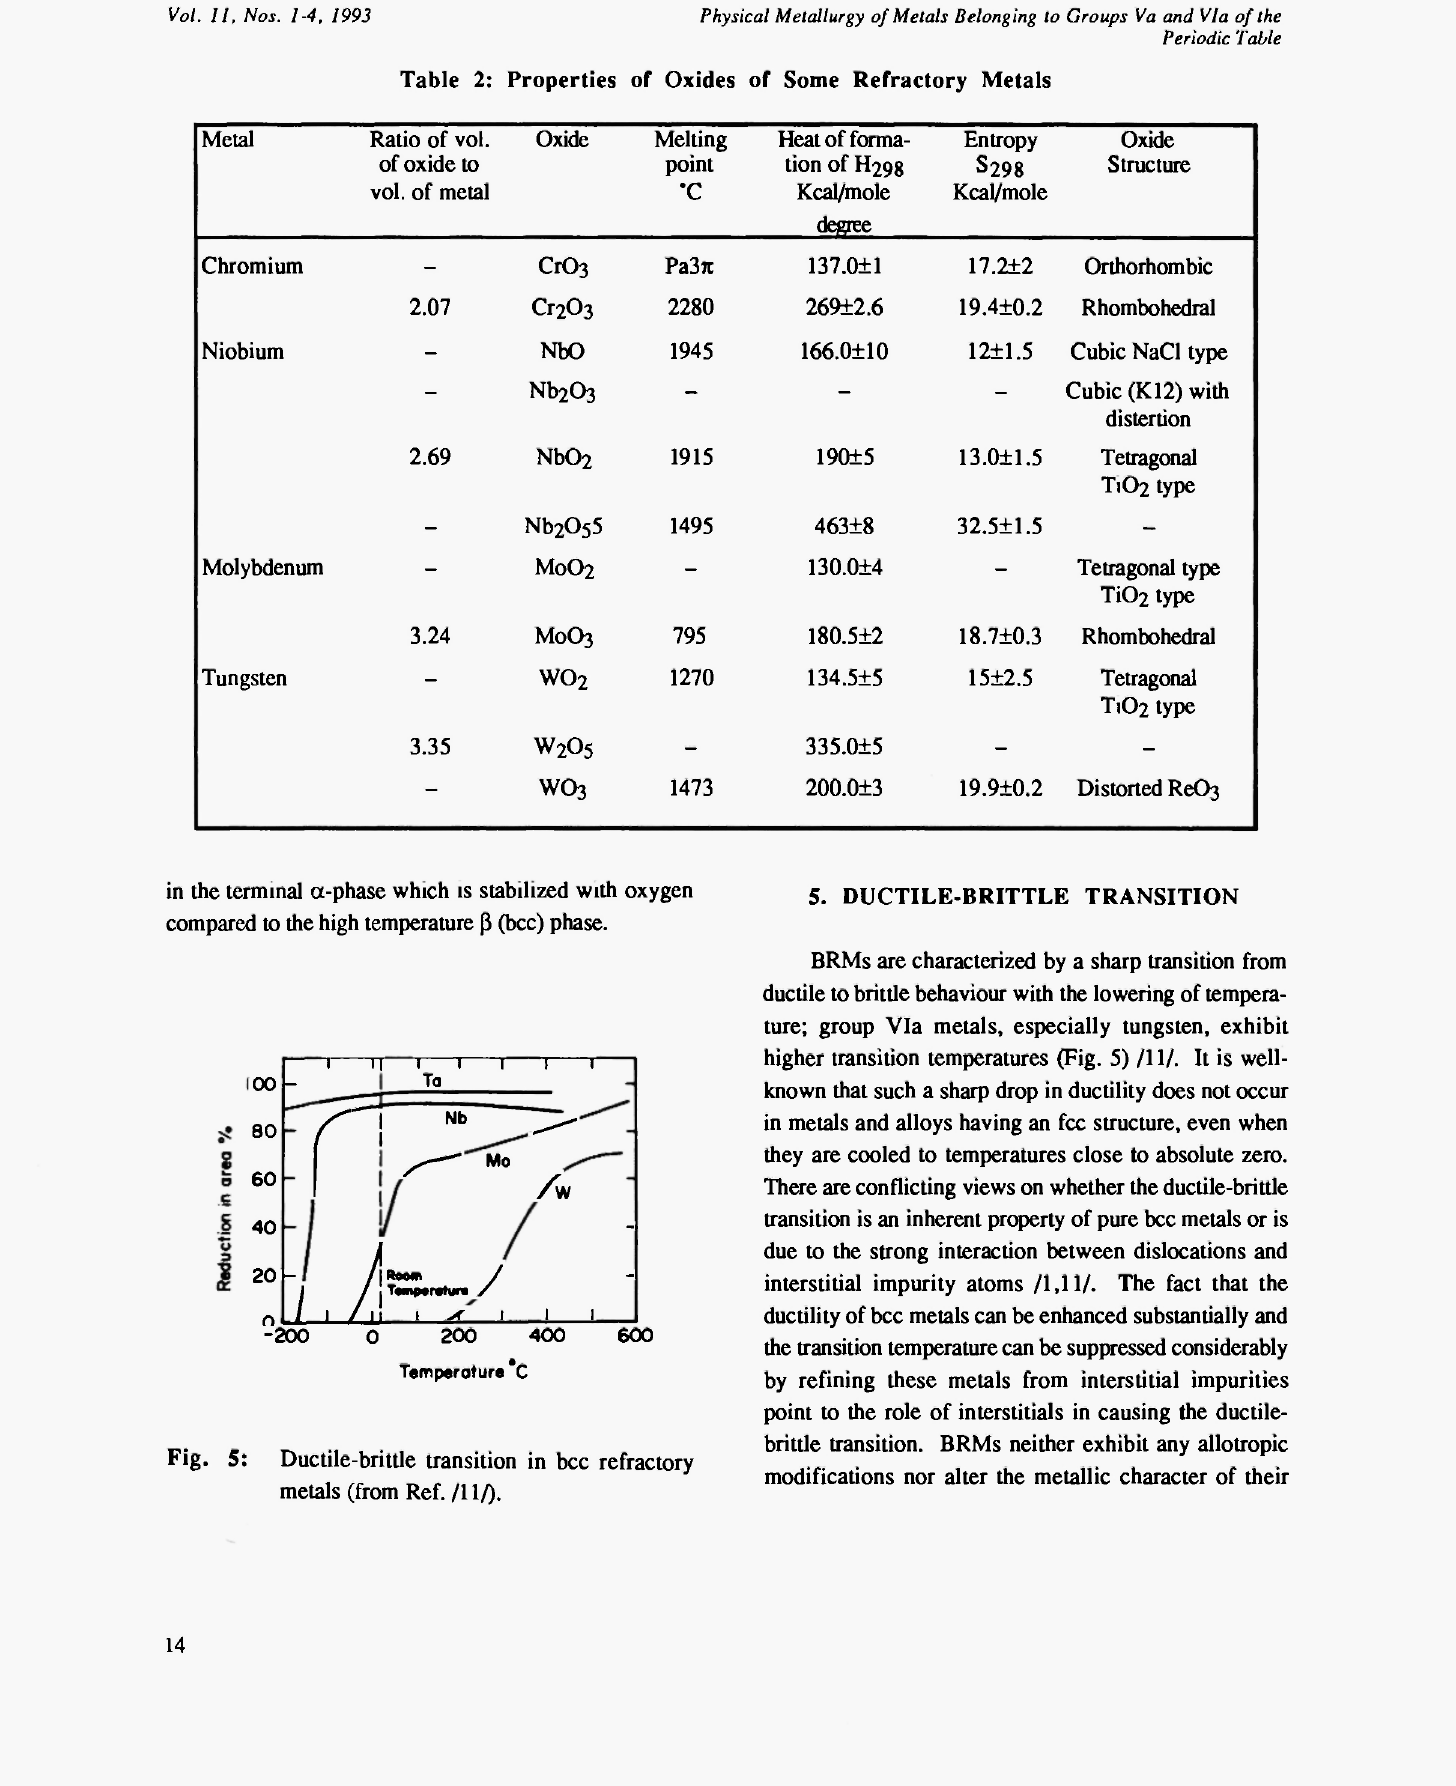
Fig. 5: Ductile-brittle transition in bcc refractory metals (from Ref.